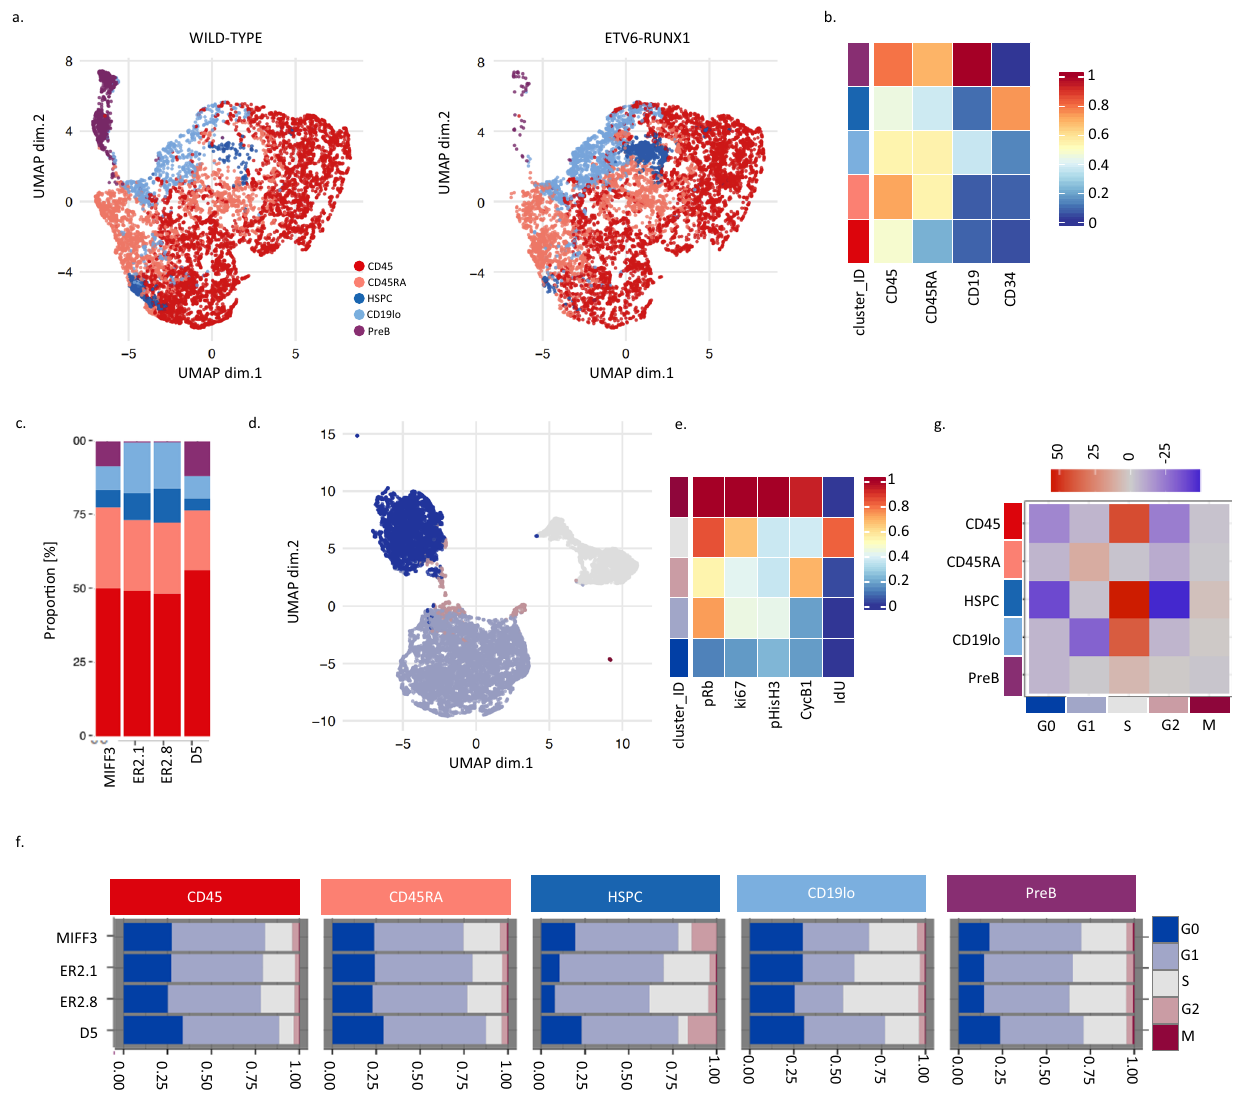
Fig. 3 | Mass cytometry reveals an accumulation of ETV6-RUNX1 expressing progenitor cellsin S phase.a Dotplots ofUMAPdimensionality reduction for cell surface markers CD45, CD45RA, CD34, and CD19 in IPSC B-cell differentiations, 10,000 cells each of wild-type and ETV6-RUNX1 knockin are displayed. b Heatmap showingmedianscaledexpressionoftheindicatedmarkersinmanuallyannotated annotated clusters. See also Supplementary Fig. 3a. c Barplot showing proportion ofcellsineachpopulationannotatedin( a )forparental(MIFF3,195473cells),ETV6- RUNX1 knock-in (ER2.1, 415891 cells; ER2.8, 379947 cells) and reverted (D5, 64072 cells) cell lines. d Dotplot for UMAP dimensionality reduction based on cell cycle markers pRb, IdU, CycB1 and pHisH3. Colors represent manually annotated SOM clusters, assigning cells to a cell cycle phase. e Heatmap showing median scaled expression of the indicated markers in the indicated clusters. See also Supple- mentary Fig. 3b. f Barplots showing proportion of cells in each phase of the cell